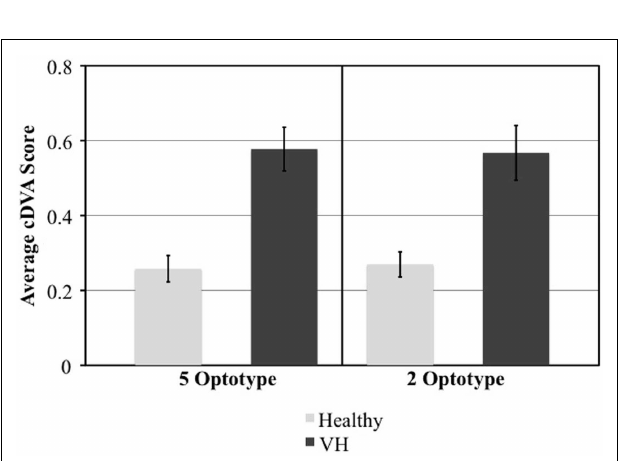
FIGURE 1 | Effect of age on mean DVA scores (mean + SD) in the normative population .